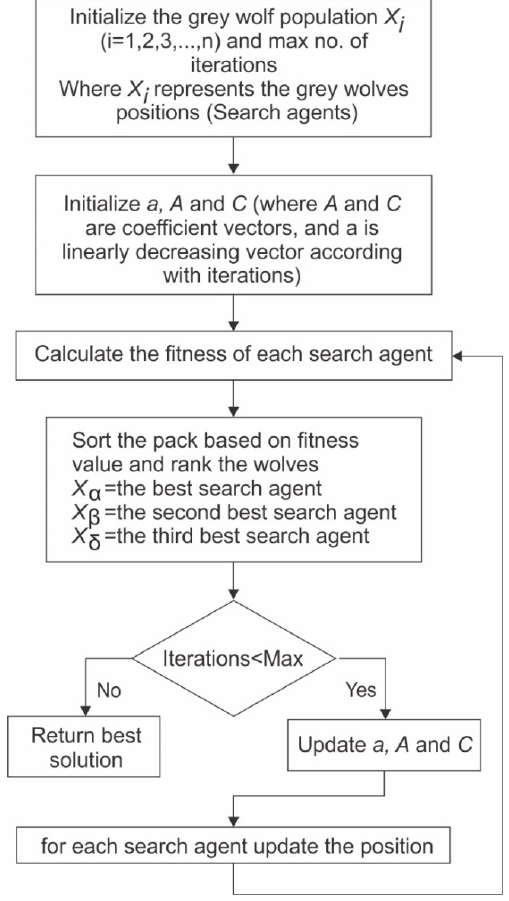
Figure 8. Flowchart of the grey wolf optimizer (GWO) algorithm.